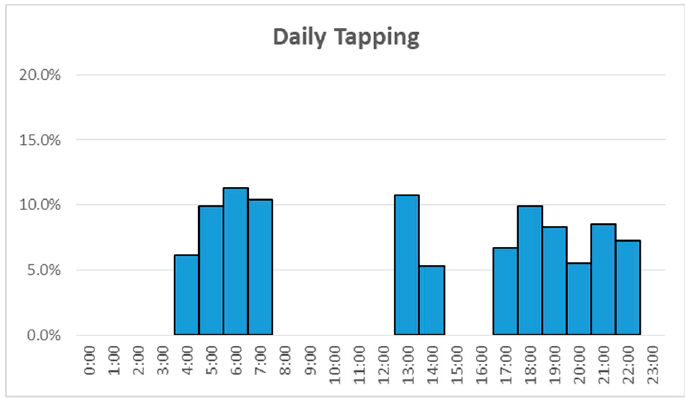
Figure 7. Tapping profile.